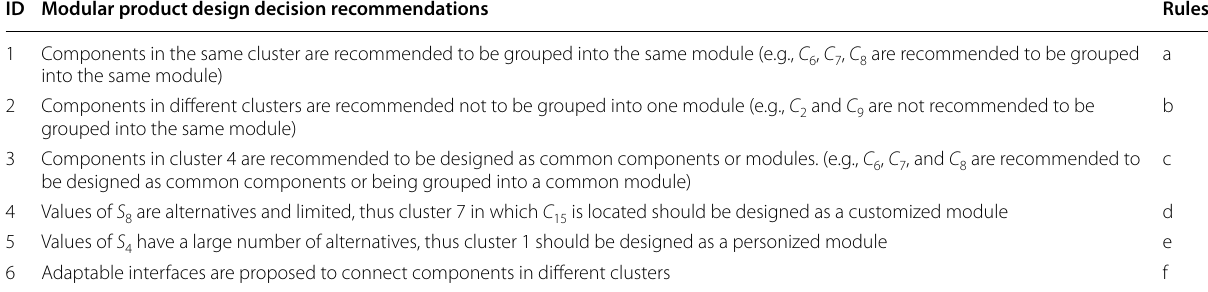
Table 10 Decision support of modular EV design ID Modular product design decision